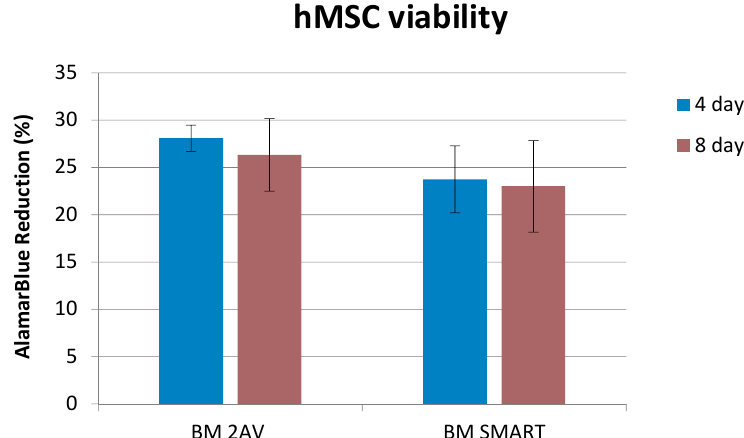
Figure 7. HMSC metabolic activity after being in contact with films of BM 2AV and BM SMART for 4 (blue) and 8 (brown) days.